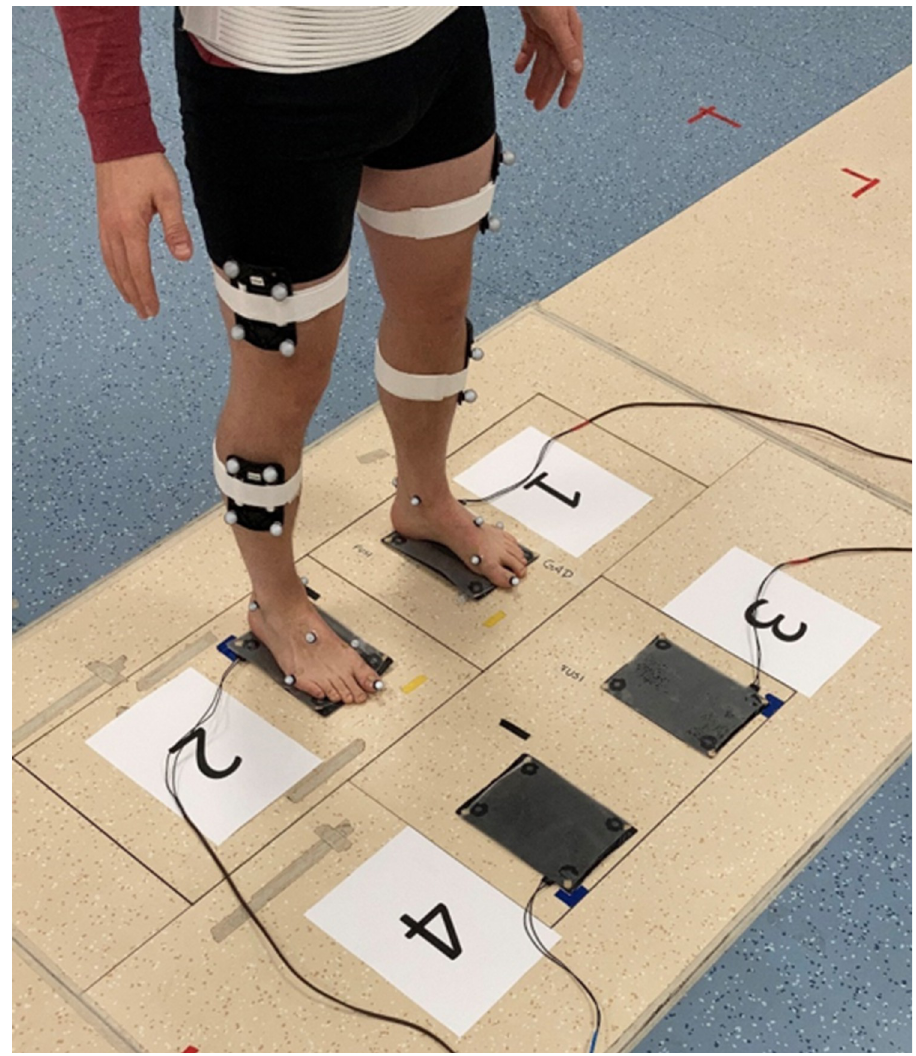
Fig 1. Experimental setup of the pressure-sensitive target mats used in Experiments 1 and 2. The spatial layout and configuration was identical in both experiments. Reflective markers for the optoelectronic motion capture system were placed on participants’ feet and lower extremities in Experiment 2